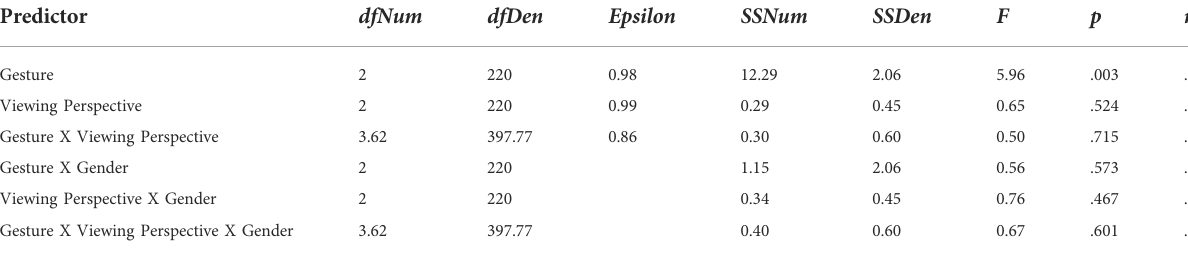
TABLE 9 Results of the mixed-measures ANOVA for the imagined collaboration with the robot. Predictor